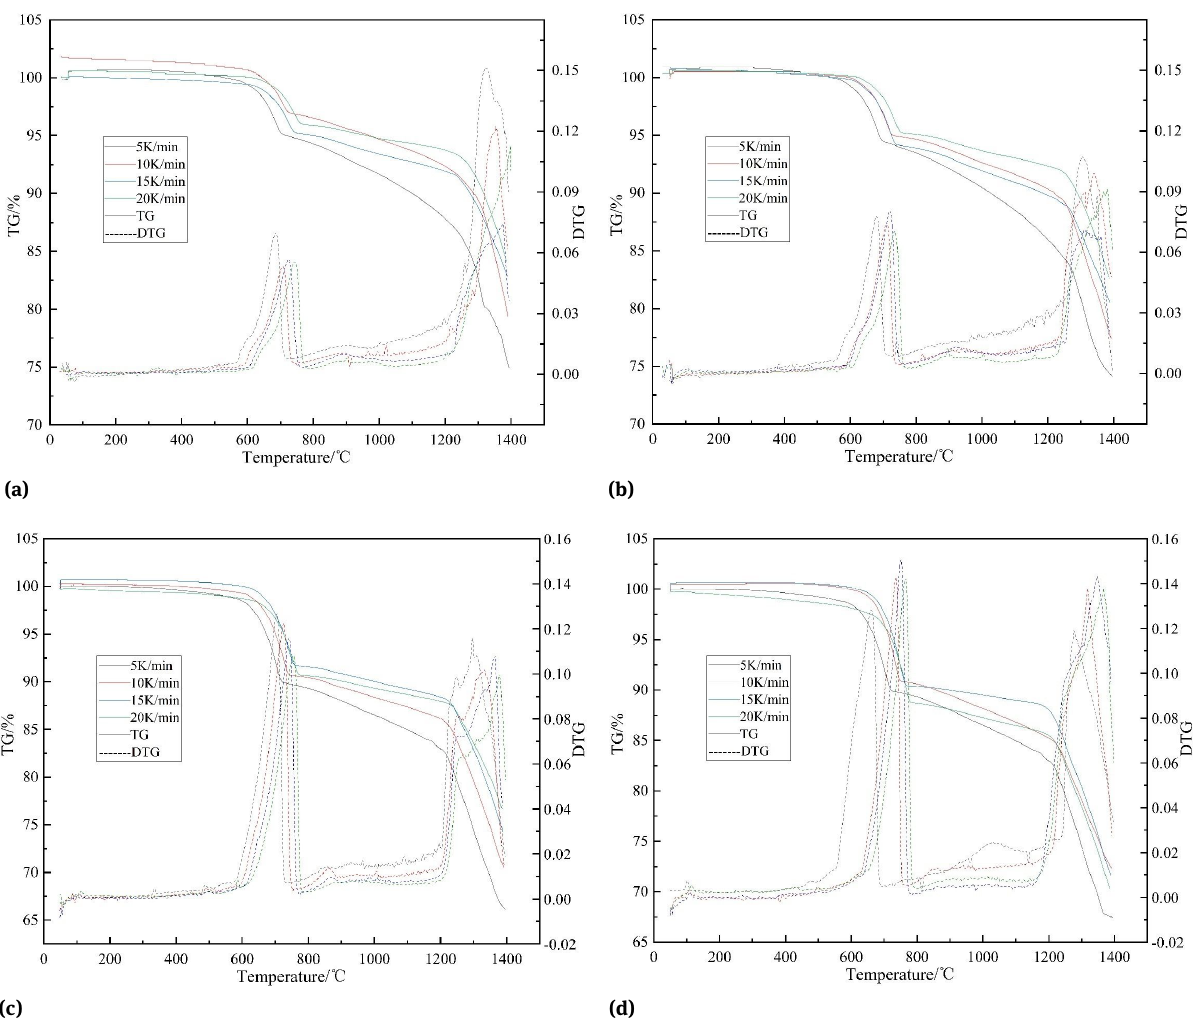
Figure 2: TG and DTG Curves of carbothermal reduction of phosphate rock with different particle sizes. (a): 38–48 µ m; (b): 48–75 µ m; (c): 75–100 µ m; (d): 100-150 µ